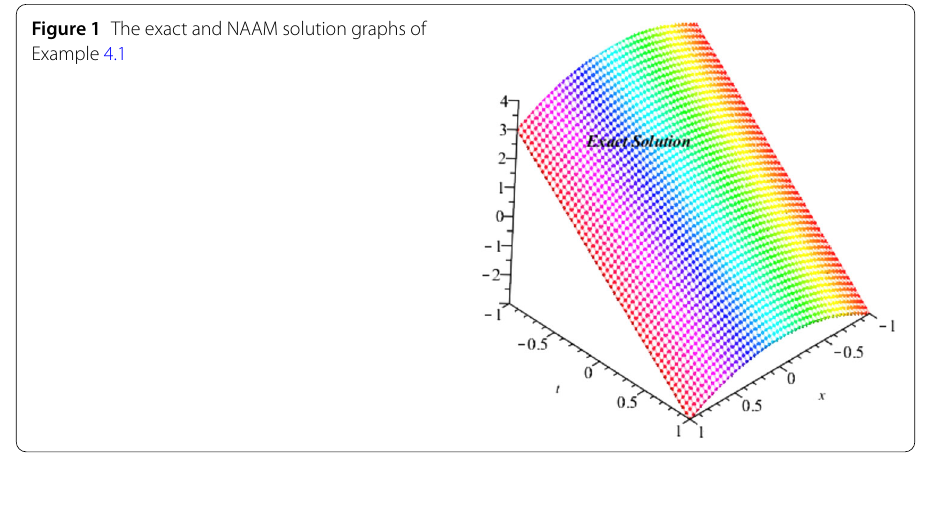
Figure 2 The fractional-order graph of Example